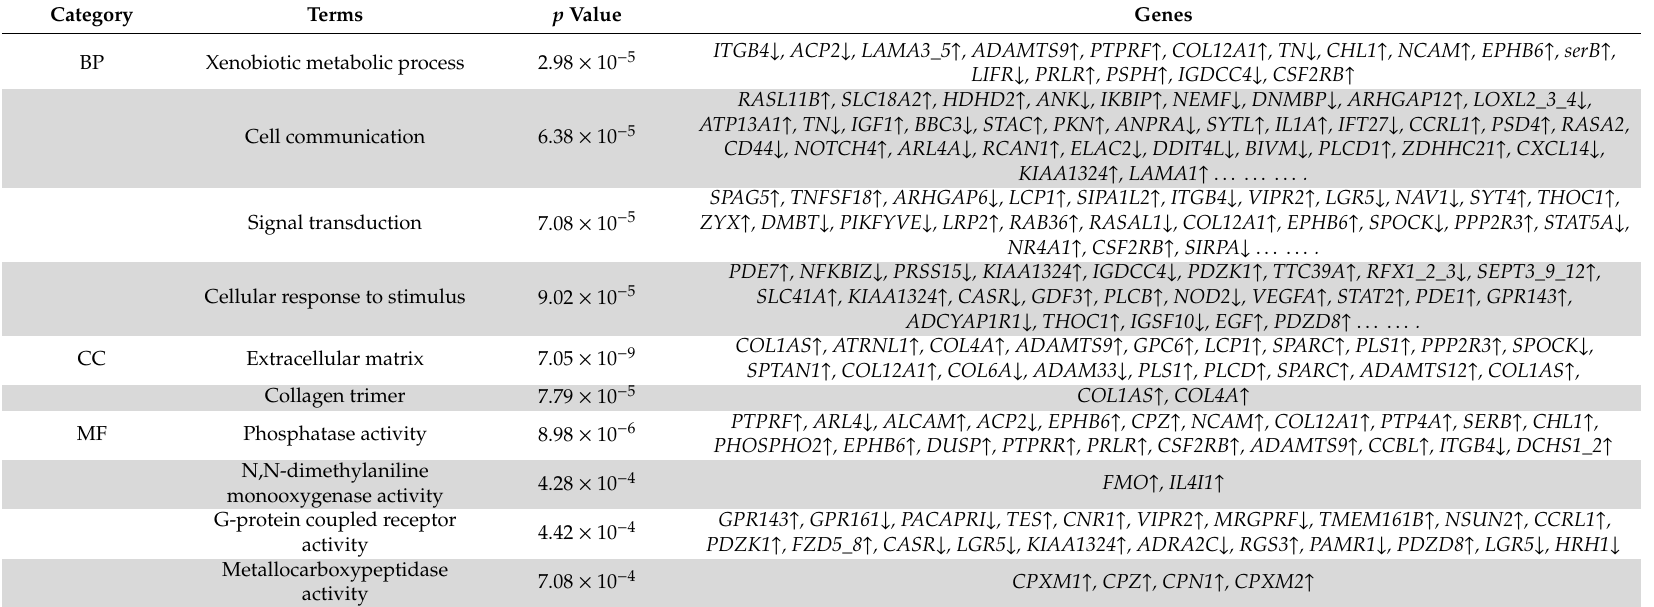
Table 3. Top 10 gene ontology (GO) terms and enriched genes in the activated uterus vs. the diapause uterus at p <